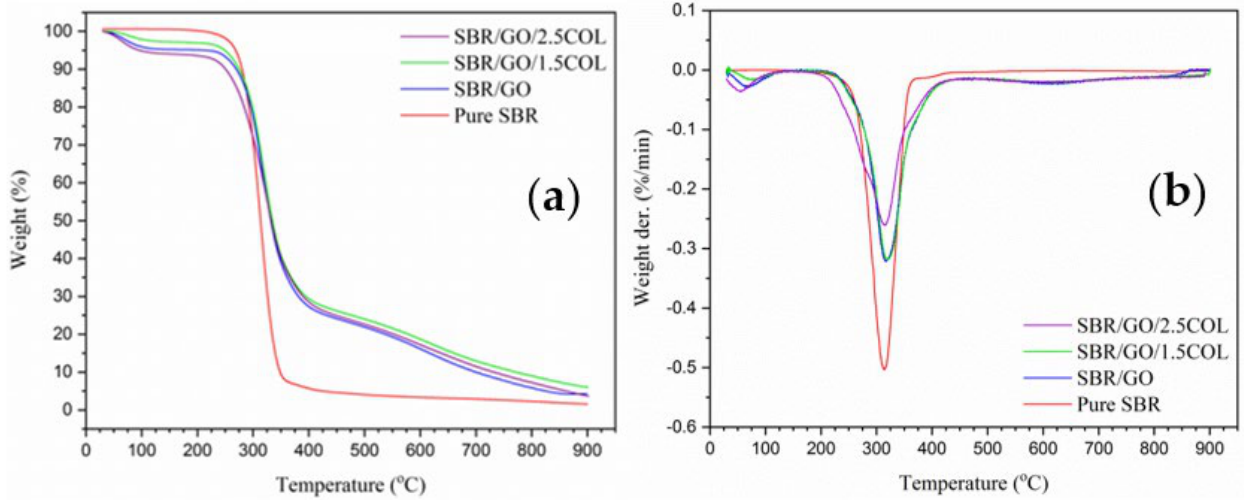
Figure 2. TGA ( a ) and DTG ( b ) curves of SBR samples.